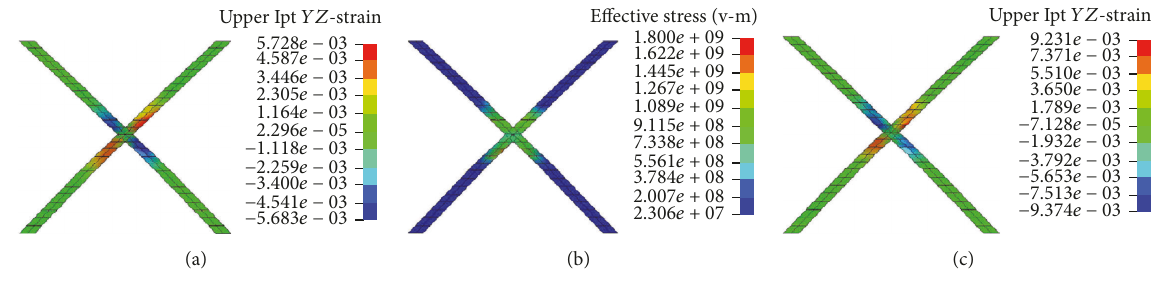
Figure 19: Strain contours of the three models: (a) model 7, (b) model 8, and (c) model 9.